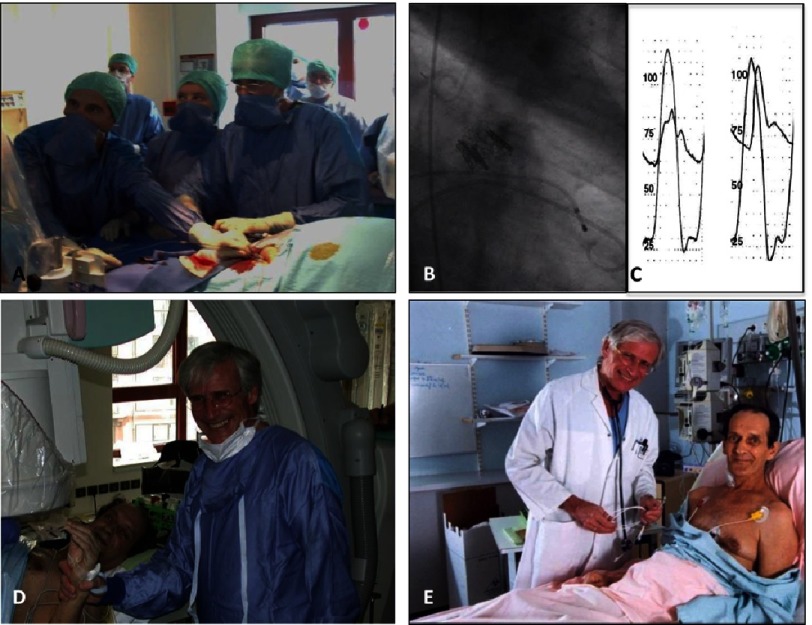
First-in-Man implantation (Rouen, April 16th, 2002).A—The complex antegrade transseptal route used for TAVR. B—View of the transcatheter valve in place within the native calcified valve and hemodynamic result (no gradient). C—The patient immediately after valve implantation and D, 8 days later.